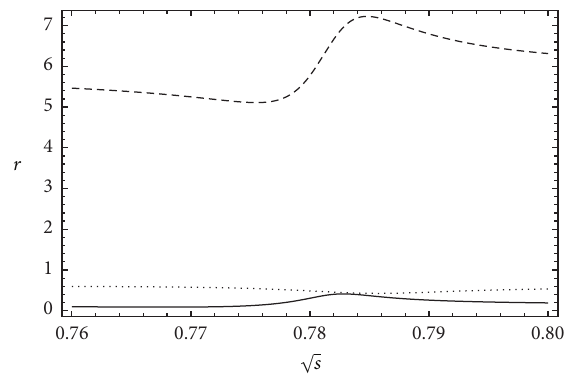
Figure 3: Plot of 𝑟 as a function of √𝑠 corresponding to central parametervaluesofCKMmatrixelementsfor 𝐵 𝜋 + 𝜋 − 𝜋 + 𝜋 − . The solid (dashed and dotted) line corresponds to 𝑟 and 𝑟 + ),